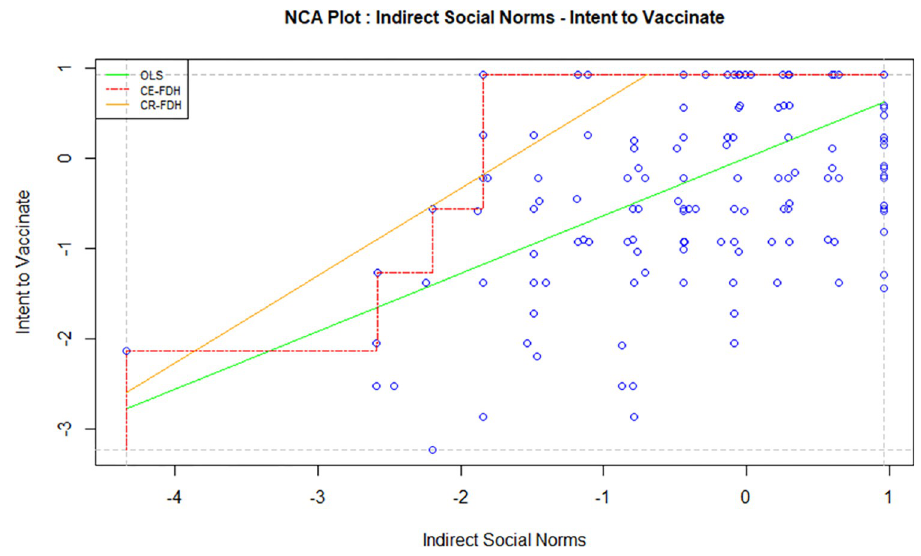
Fig 4. NCA (indirect social norms—intention).